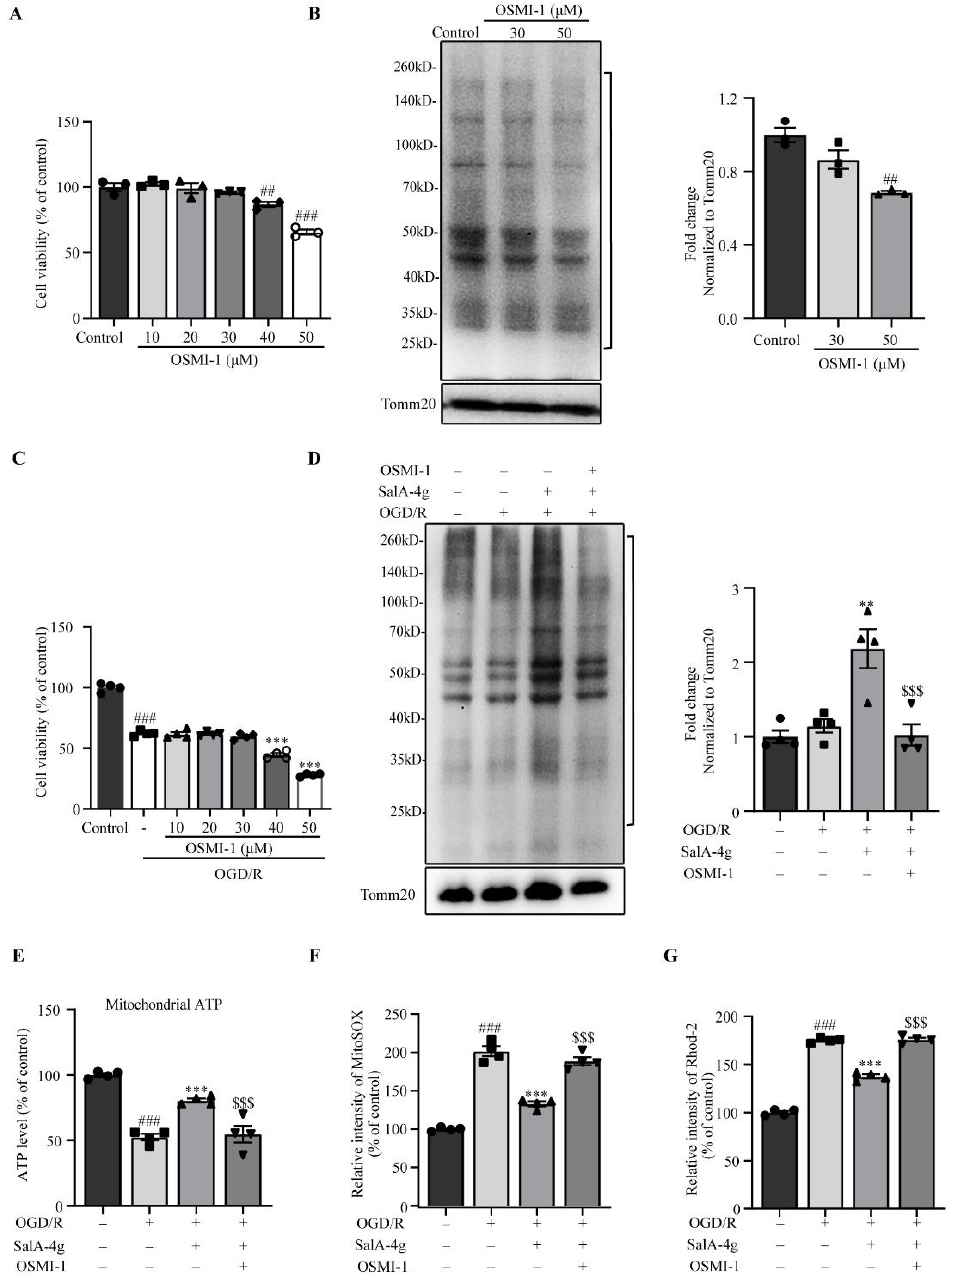
Figure 7. O-GlcNAcylation on mitochondrial proteins is involved in the regulation of SalA-4g on mitochondrial stress response in cortical neurons under OGD/R stress. ( A ) Histogram depicting the cell viability of primary cortical neurons exposed to different concentrations of OSMI-1 for 24 h. ( B ) Western blot analysis of mitochondrial O-GlcNAcylation in neurons exposed to 30 µ M and 50 µ M of OSMI-1 for 24 h. ( C ) Histogram depicting the cell viability of control cells, cells exposed to 2.5 h of OGD and 24 h of reoxygenation alone, and cells treated with different concentrations of OSMI-1 during the OGD/R period. ( D ) Western blot analysis of mitochondrial O-GlcNAcylation in OGD/R injury neurons with treatment of SalA-4g (200 µ M) or SalA-4g (200 µ M) + OSMI-1 (30 µ M).